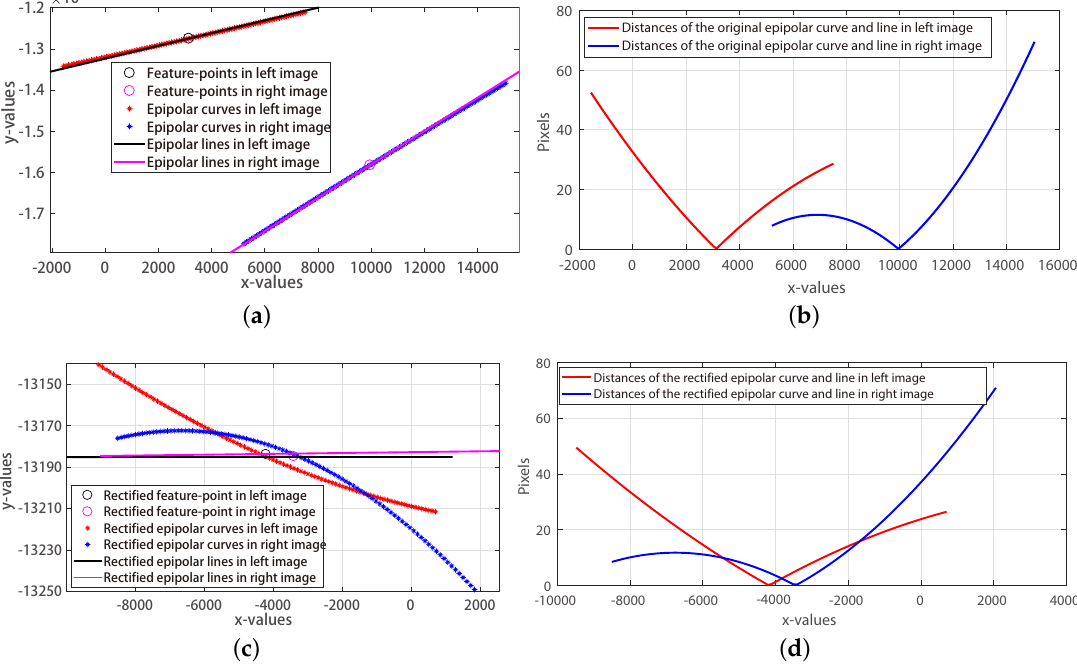
Figure 2. The most different original and rectified epipolar curves and lines. ( a , b ) The original epipolar curves and lines and their corresponding distances. ( c , d ) The rectified epipolar curves and lines and their corresponding